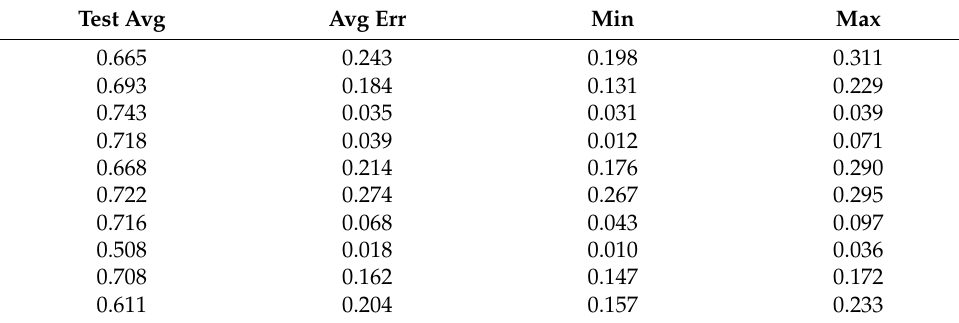
Table A24. Set 1, trials 11–20 data (average actual PR values).